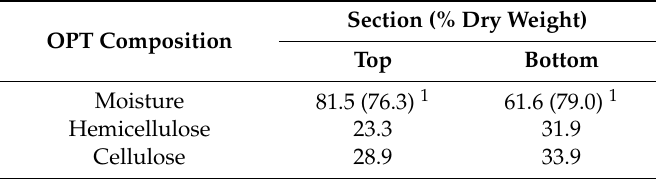
Table 1. The chemical composition of the 21-year-old OPT (OPT21). OPT Composition